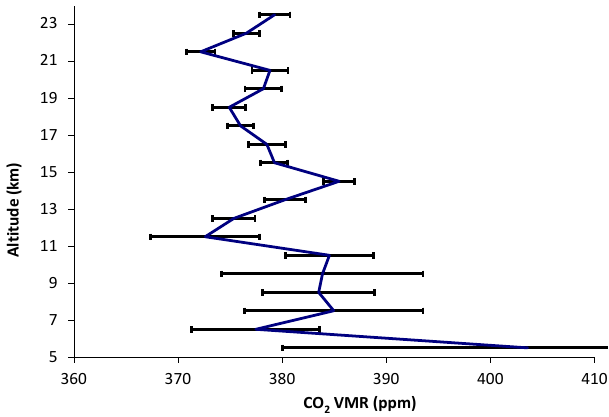
Figure 9. Three-year (2009–2011) global median of cloud-free CO 2 VMR in the 5–24km range (869 profiles). The error bar shows the standard error at each 1km altitude bin (centered at 5.5 to 23.5km).